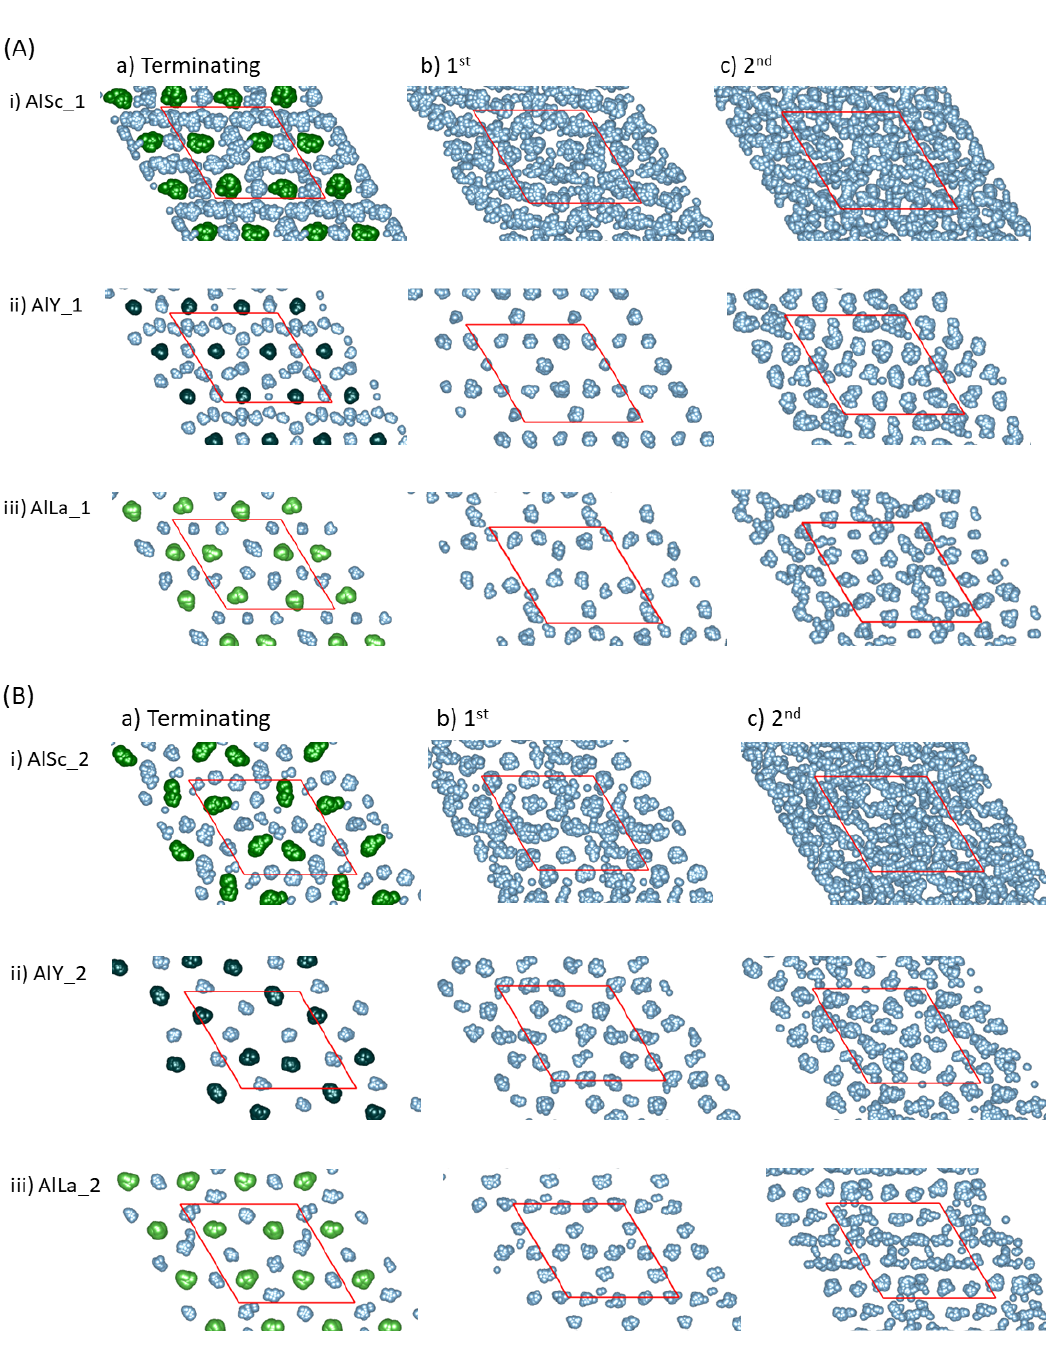
Figure 5. Time averaged atomic arrangements of the metal layers at the Al( l )/ γ -Al 2 O 3 {1 1 1} AlM_1 ( A ) and at Al( l )/ γ -Al 2 O 3 {1 1 1} AlM_2 ( B ) interfaces for 4.5 ps. The silvery spheres represent Al; green, dark-green and light-green ones for Sc, Y or La, respectively. The segregated Group 3 atoms show strong localization. For the large Y and La atoms segregated interfaces, the 1st Al layers contains holes on top of the segregated Y and La atoms. ( a ) terminating metal atoms, ( b ) 1st Al atoms, ( c ) 2nd Al atoms, ( i ) Al( l )/ γ -Al 2 O 3 {111} AlSc , ( ii ) Al( l )/ γ -Al 2 O 3 {111} AlY , ( iii ) Al( l )/ γ -Al 2 O 3 {111} AlLa .